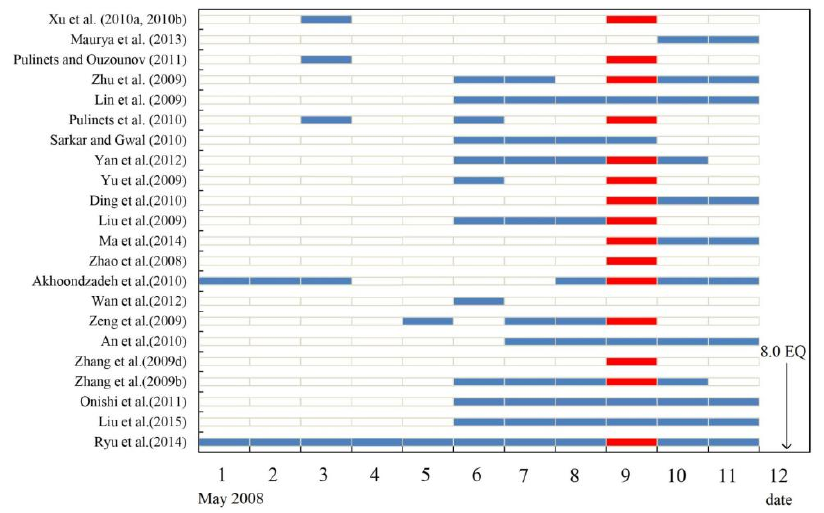
Figure 4. Statistical ionospheric variations during the period of 1–12 May 2008. Blue lines represent an anomaly and red lines represent a distinct anomaly. The Wenchuan M S 8.0 EQ that occurred on 12 May 2008 is labeled by an arrow.